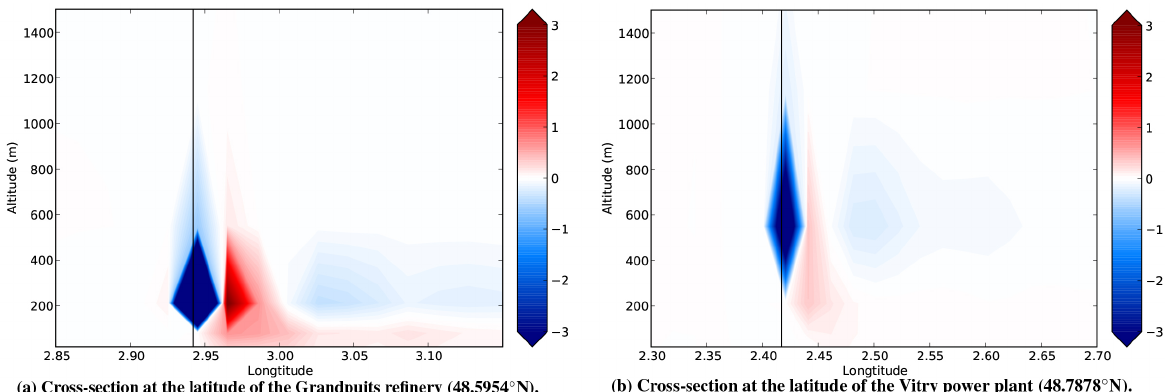
Fig. 5. Vertical cross sections of the differences (PinG – Reference) in the mean concentrations of NO x (ppb): (a) Grandpuits refinery, (b) Vitry power plant. The black line corresponds to the longitude of the industrial